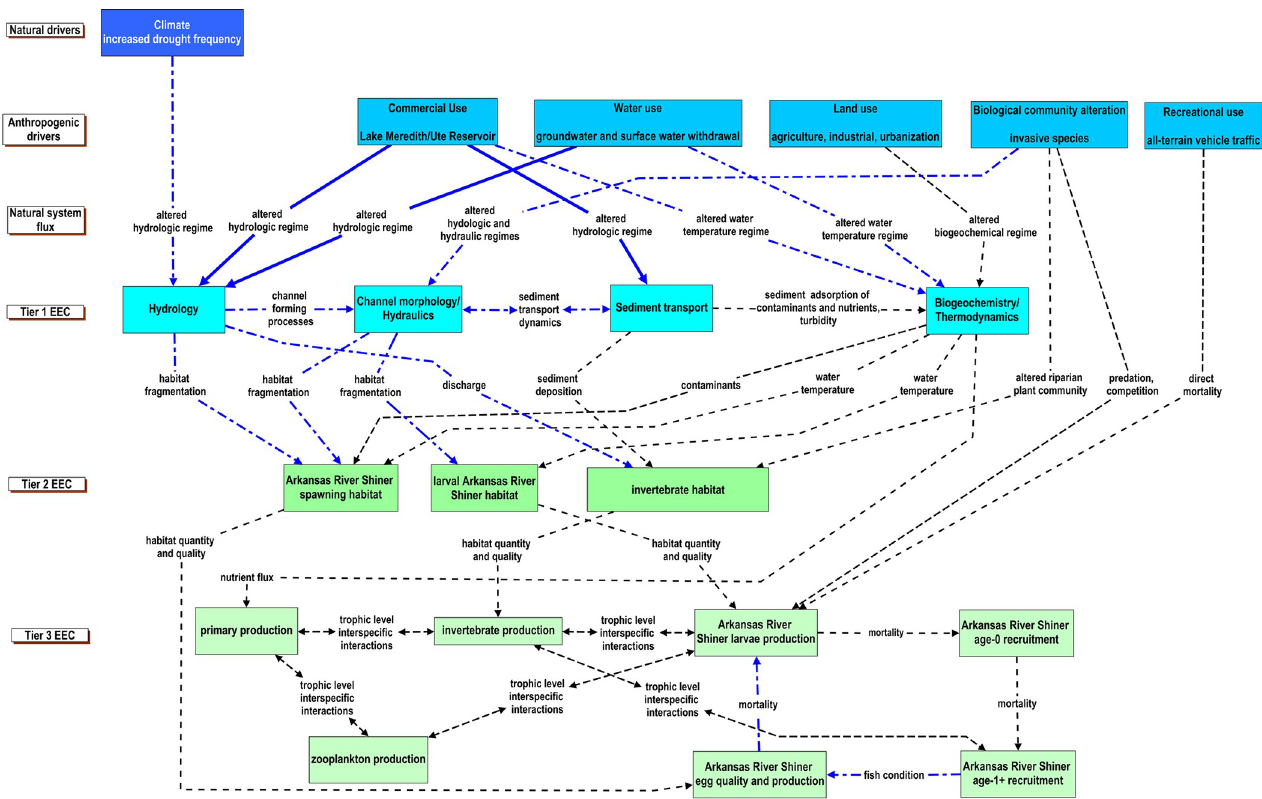
Fig 4. Conceptual model describing the relationship of natural and anthropogenic drivers to essential ecosystem characteristics (EECs) affecting the recruitment of the Arkansas River Shiner in the South Canadian River in New Mexico, Texas, and Oklahoma. Essential ecosystem characteristics are groupings of ecosystem components. Tier 1 EECs represent physical and chemical effects; fundamental measures of process that are directly affected by anthropogenic and natural drivers. Tier 2 EECs represent a broad habitat category that is intended to encompass the physical, chemical, and biological components of the riverine habitats that influence reproduction, growth, and survival of biotic communities. The Tier 3 EECs represent components of the biological systems that respond to changes in the hierarchical components of the conceptual model. The strength of our understanding of how natural and anthropogenic drivers interact with habitats, biological systems, and fish in large rivers is represented by the different types of lines in the figure. Solid blue lines depict a strong understanding of the relationship, the dotted-dashed blue line represents a moderate understanding of the relationship, and the black dashed line represents a weak understanding of the relationship. The different types of lines also represent the strength of our understanding of within EEC-tier